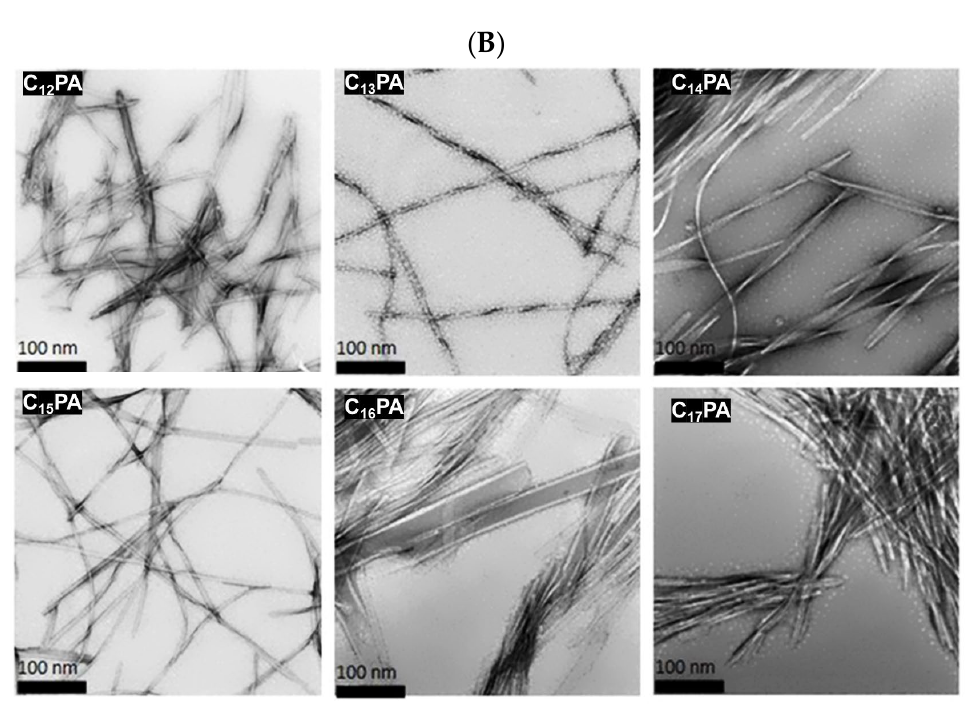
Figure 3. ( A ) SEM images of PA gel networks coated with 4 nm Au – Pd. ( B ) TEM images of PA nanofibers stained with 2% ( w / v ) uranyl acetate.